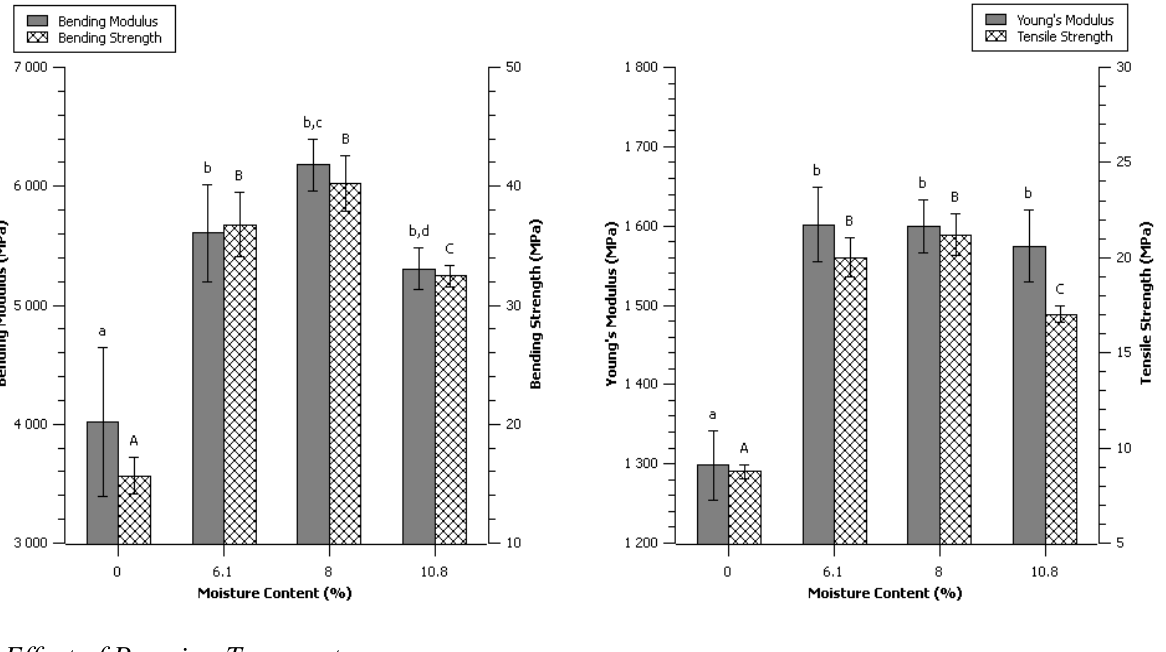
Figure 3. Effect of initial moisture content. Data are given as mean ± confident interval (95%). The letters on top of the column express significant difference of means according to Scheffé test with a 95% confident level. Small letters for moduli and capital letters for